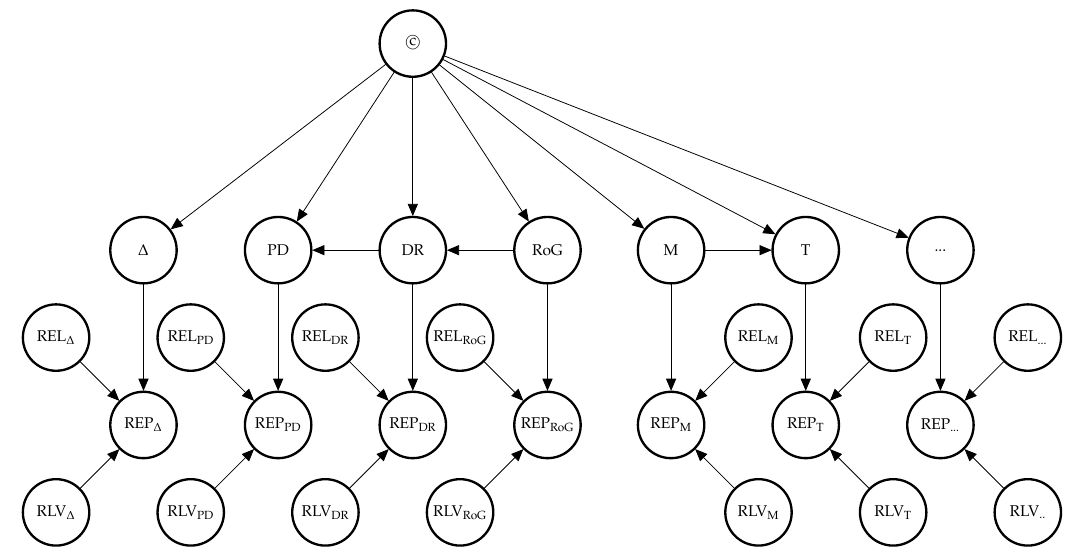
Figure 1. Graph of the Bayesian network with one report for every causal indicator variable. The dots indicate that there might be further indicators of causality not considered here. As explained in text, we here take it that M entails T and hence introduces an arrow from M to T which is not in [20]. REL and RLV act as evidential modulators of data ( REP nodes).